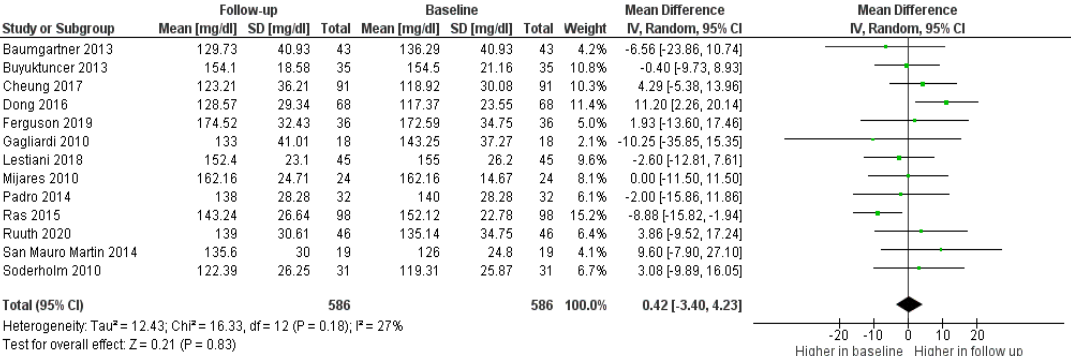
Figure 3. Forest plot comparing baseline and follow up LDL-c among participants in the control/pla- cebo groups.